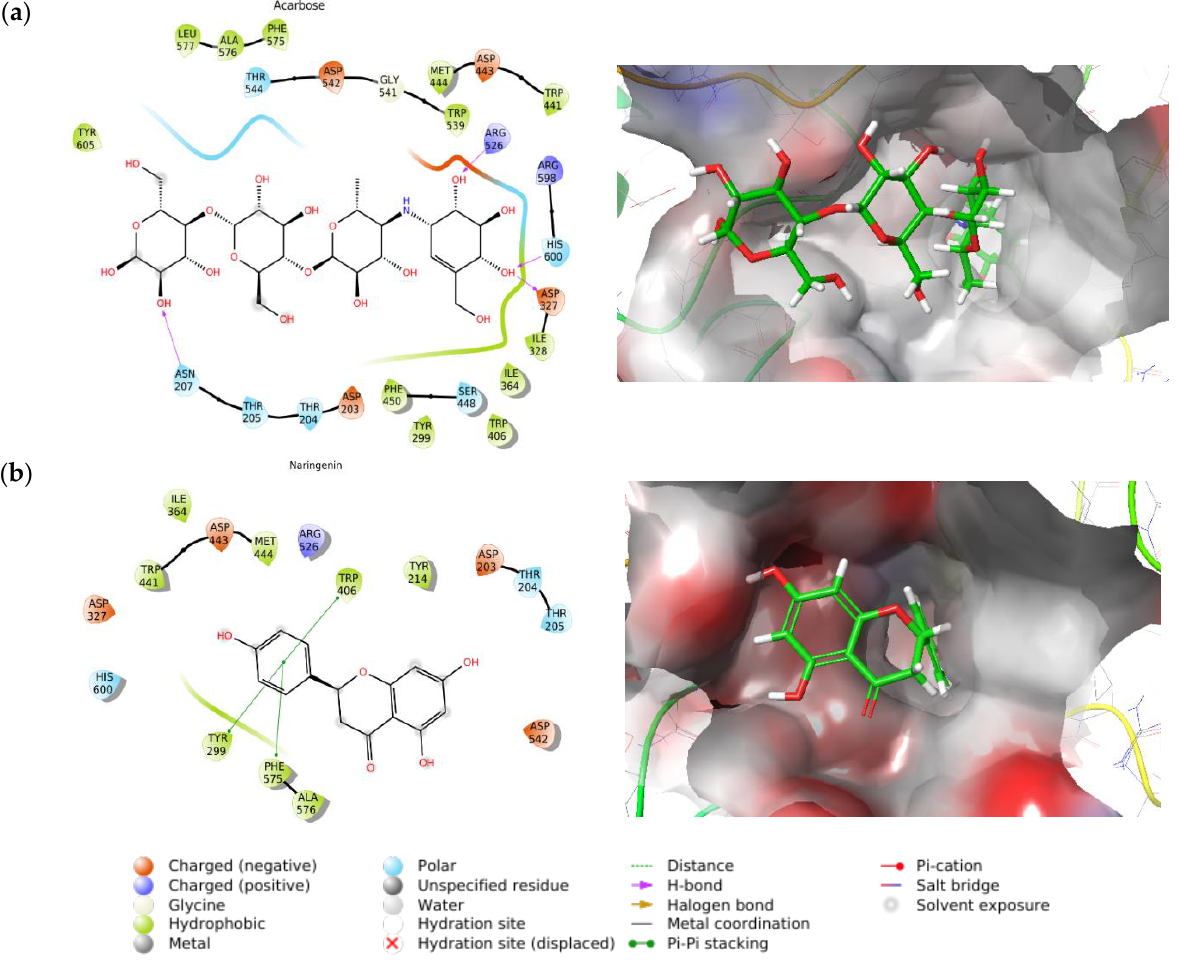
Figure 2. Molecular interactions of: ( a ) acarbose and ( b ) naringenin, with α -glucosidase receptor.